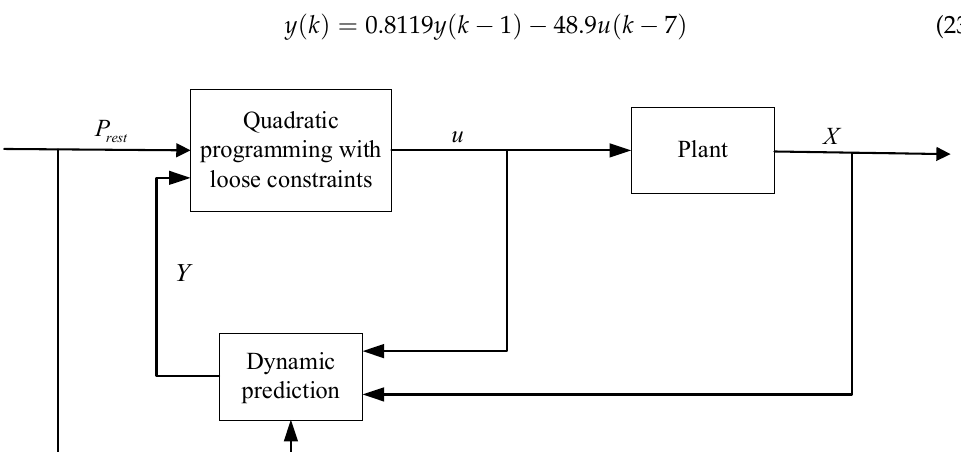
Figure 2. A general block diagram for the proposed method.